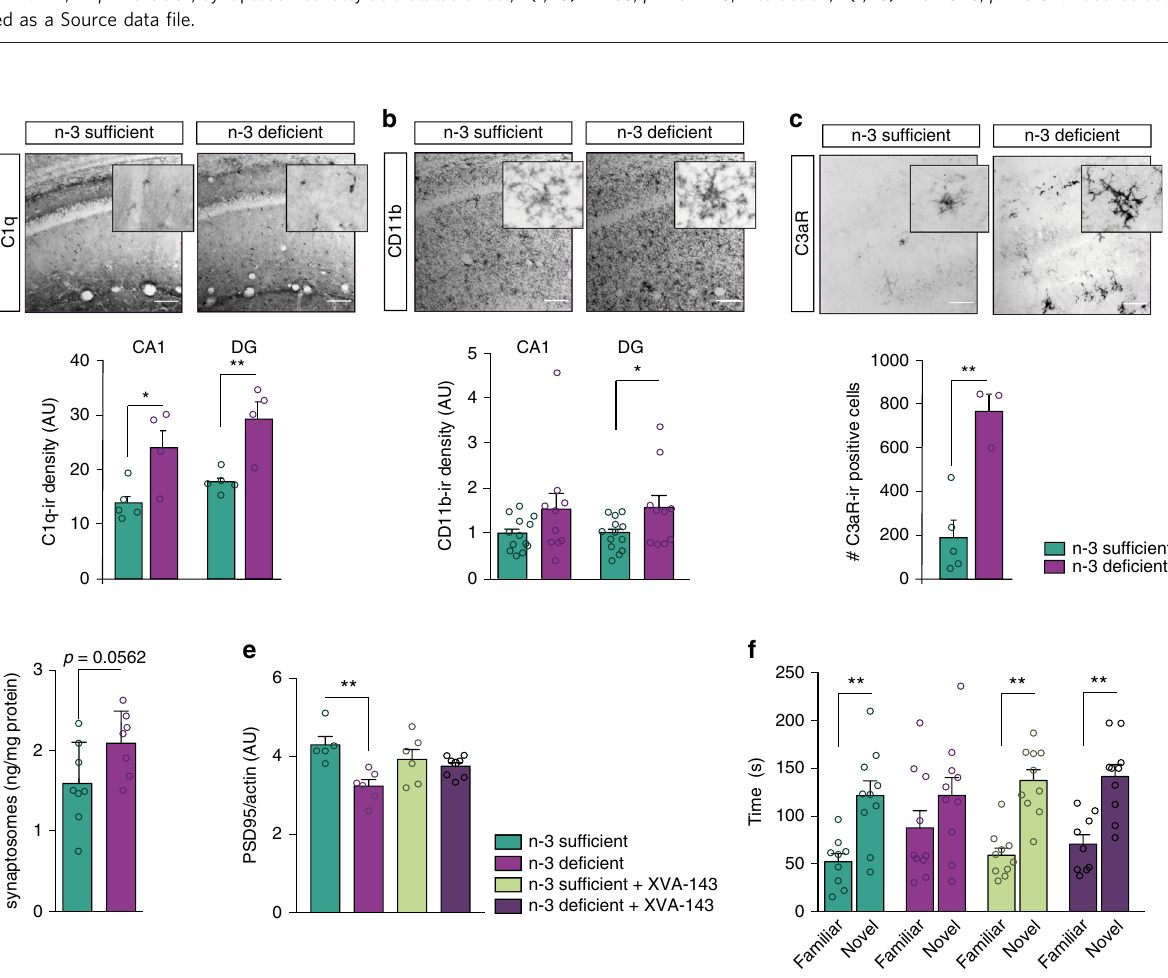
Fig. 4 Maternal n-3 PUFA de fi ciency exacerbates microglia-mediated shaping of neuronal networks in a complement-dependent manner. a – c Representative images and quanti fi cation of C1q, CD11b, and C3aR immunostaining in coronal sections of n-3 de fi cient and n-3 suf fi cient mice hippocampus. Scale bar = 100 μ m. Means ± SEM; n = 3 – 13 mice per group. Two-tailed unpaired Student ’ s t -test; t = 1.553, p = 0.135, CD11b CA1; t = 2.114, * p = 0.466, CD11b DG; t = 0.5495, * p = 0.0223 C1q CA1; t = 3.938, ** p = 0.0056, C1q DG; t = 4.91, ** p = 0.0027, C3aR, total hippocampus. d Protein quanti fi cation (ELISA) reveals that synaptosomes from n-3 de fi cient mice express more C3 than n-3 suf fi cient animals. Means ± SEM; n = 7 – 8 mice per group; Two-tailed unpaired Student ’ s t -test; t = 2.097, p = 0.0562. e Quanti fi cation of PSD95 protein expression in n-3 suf fi cient vs n-3 de fi cient mice treated with XVA-143 or its vehicle. Means± SEM; n = 5 – 8. Two-way ANOVA followed by Bonferroni post hoc test: diet effect, F (1,21) = 11.89, p = 0.0024; treatment effect, F (1,21) = 0.1436, p = 0.708; interaction, F (1,21) = 5.977, p = 0.0234; n-3 suf fi cient vs n-3 de fi cient, ** p < 0.01. f Time spent in novel vs familiar arm in the Y maze task in n-3 suf fi cient vs n-3 de fi cient mice treated with XVA-143 or its vehicle. Means ± SEM; n = 9 – 10 mice per group. Paired t -test: n-3 suf fi cient group, ** p = 0.0019; n-3 de fi cient group, p = 0.357; n-3 suf fi cient + XVA-143 group, ** p = 0.0013; n-3 de fi cient + XVA-143 group, ** p = 0.0099. Source data are provided as a Source data fi MFG-E8 and VNR vs a scrambled control (sc-cRGD), to n-3 PSD-95 expression in the hippocampus of n-3 de fi cient mice de fi cient vs n-3 suf fi cient mice animals and quanti fi ed the (Supplementary Fig. 7H). These results indicate that modula- expression of the post-synaptic protein PSD-95. Blocking tion of the microglial phagocytic capacity by early-life PUFAs MFG-E8 action on microglia did not prevent the reduction in is PS recognition-independent.